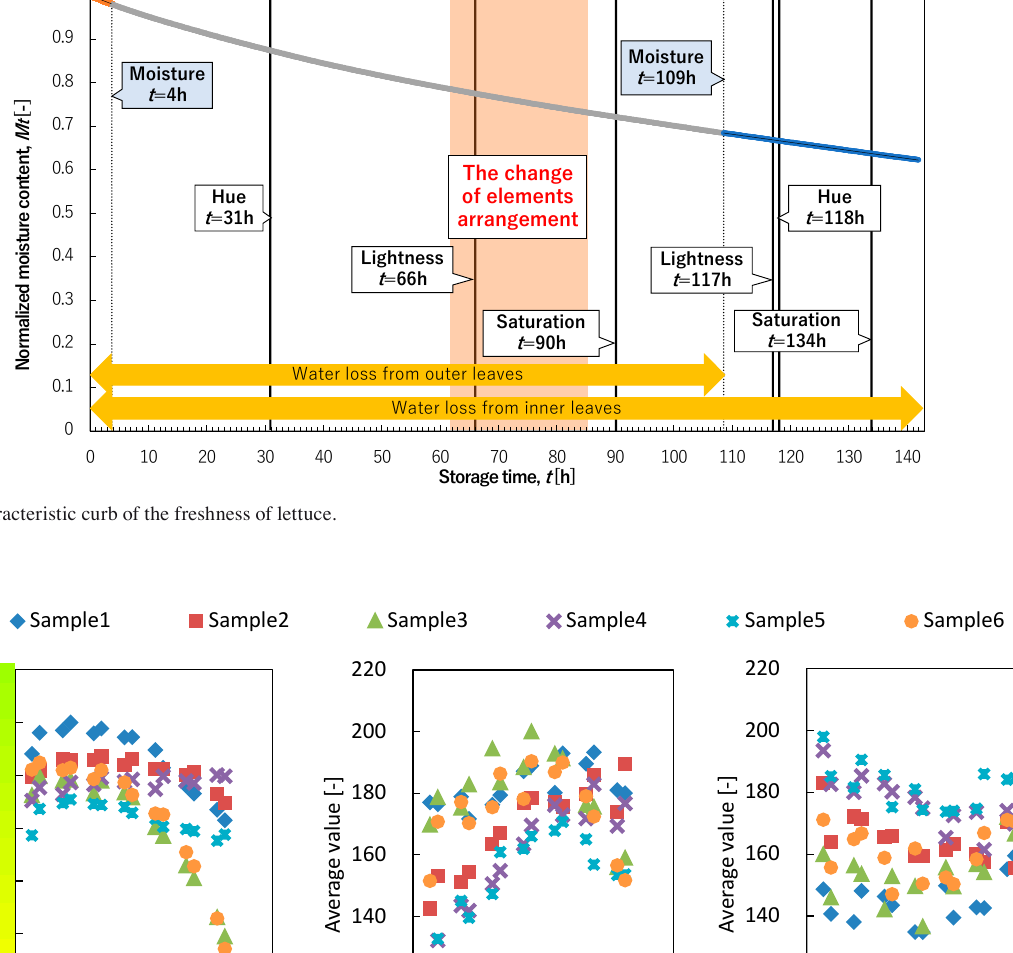
FFiigg.. 1122 CCoolloorr cchhaannggee ooff lleettttuuccee lleeaavveess 705